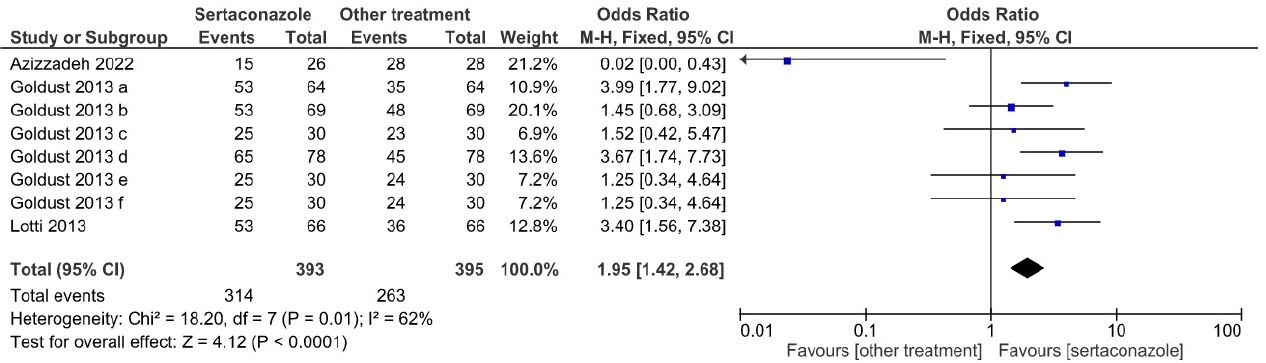
Figure 3. Forrest plot illustrating the effect of sertaconazole vs. other treatments in the eight selected studies for the mild SI at 28 days of treatment (OR with 95% confidence interval, heterogeneity, and overall effect). Complementary, the cumulated frequency of moderate or severe SI in the sertaconazole vs. other treatments groups (Forrest plot shown in Figure 4) yielded an OR of 0.51 (95% confidence interval 0.37–0.70), again favoring sertaconazole. The χ 2 value was 18.20 ( p = 0.01) and the overall effect featured a z of 4.12 ( p < 0.0001).